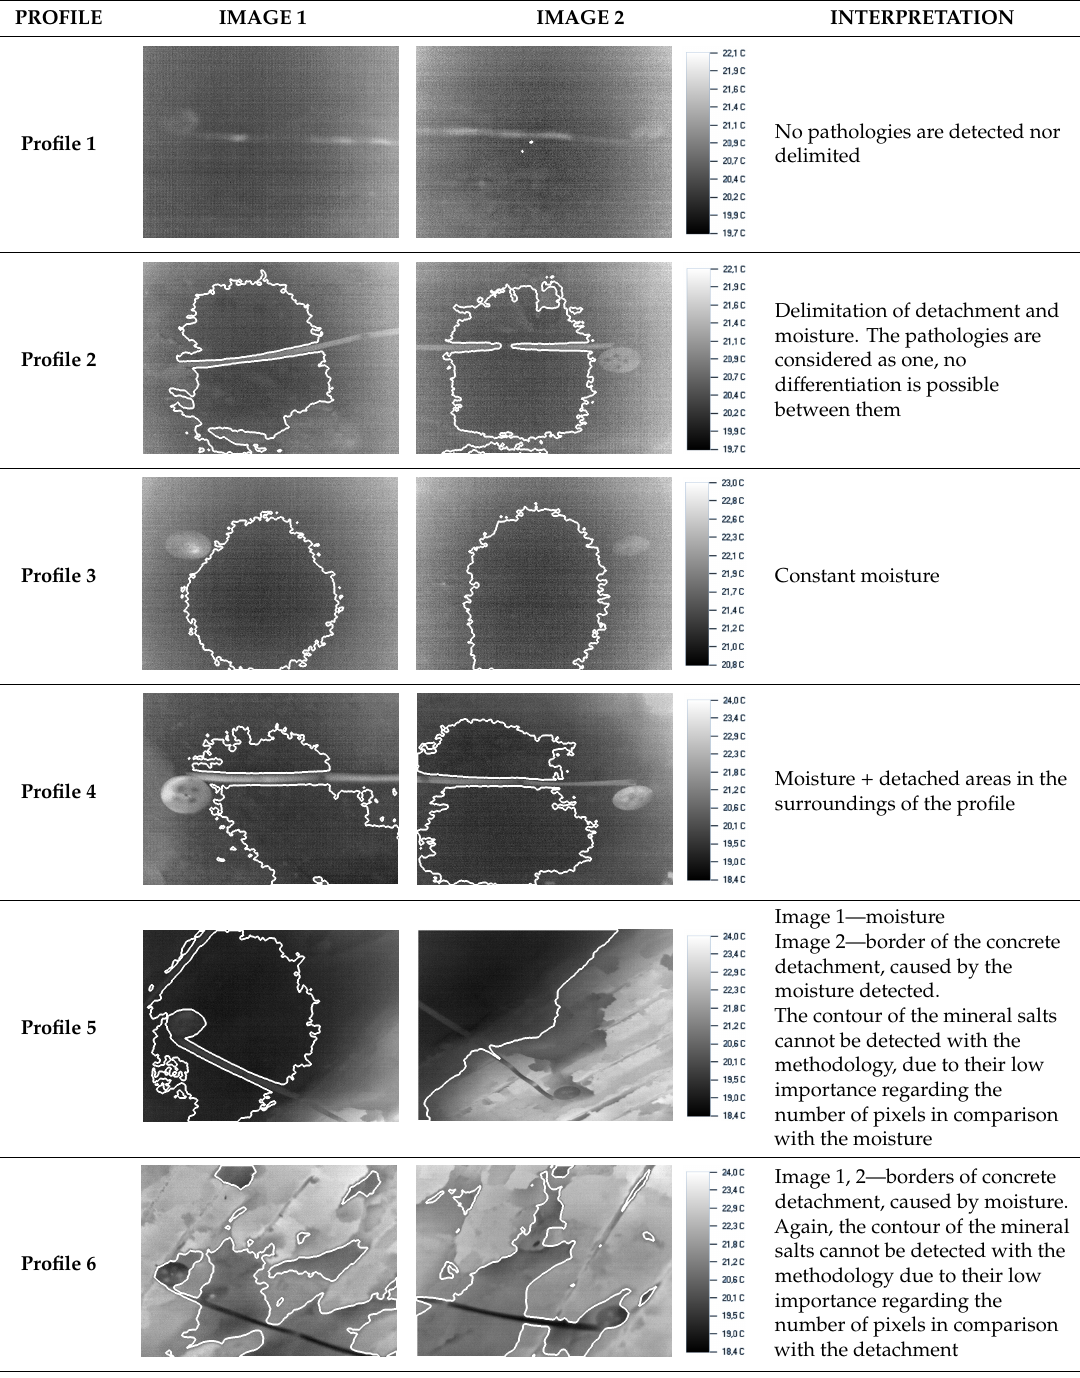
Table 4. Delimitation of pathologies and interpretation. Humidity is detected by its lower temperature regarding the environment, due to its higher thermal inertia. The delimitation is shown with a white line, placed on the original thermal image.